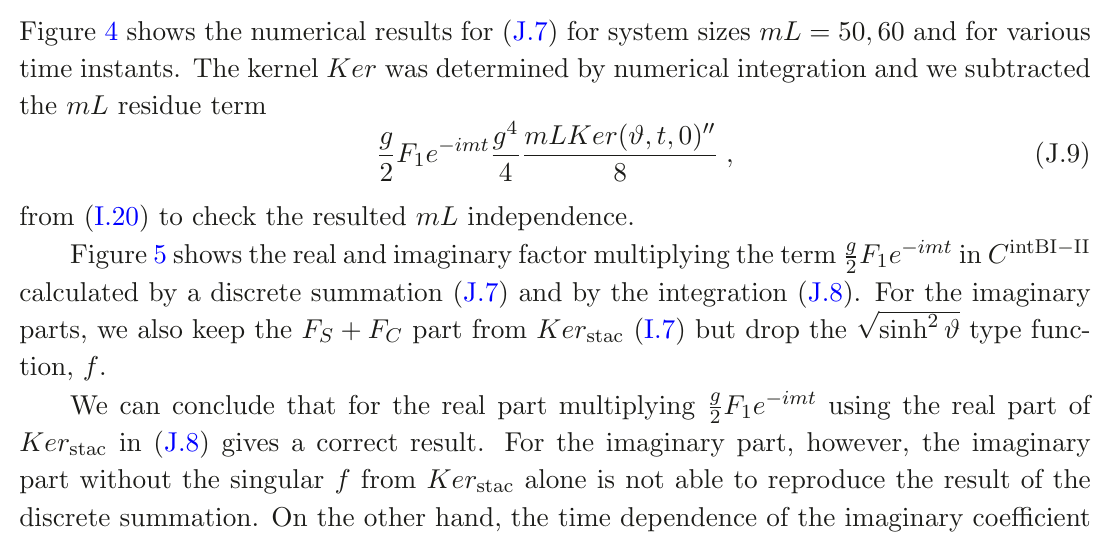
Figure 5. Real and imaginary parts of e imt C intBI − II a continuous integral using Ker stac for time instants mt = 0 . 1 , 1 , 2 . 5 , 5 , 7 . 5 , 10 , 15 , 20 , 25 , 30 , 35 and 40 for a quench in the Ising model. The red dots correspond to system sizes mL = 60 and the blue dots to the analytic results. g =